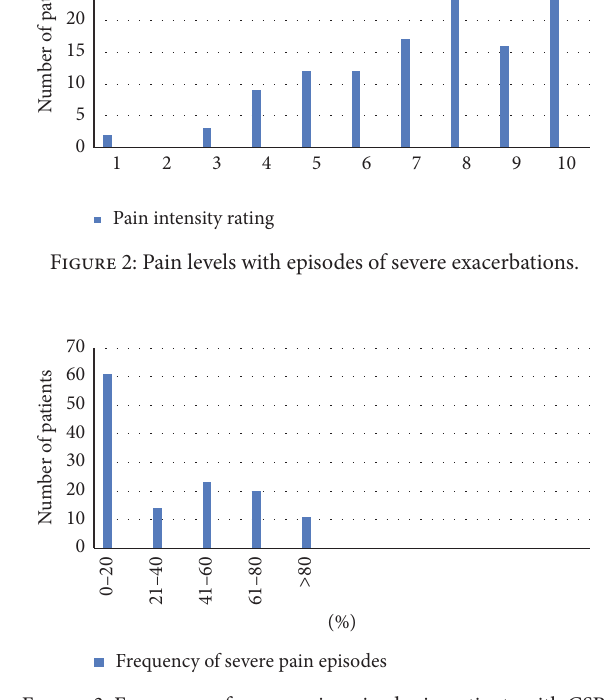
Figure 3: Frequency of severe pain episodes in patients with